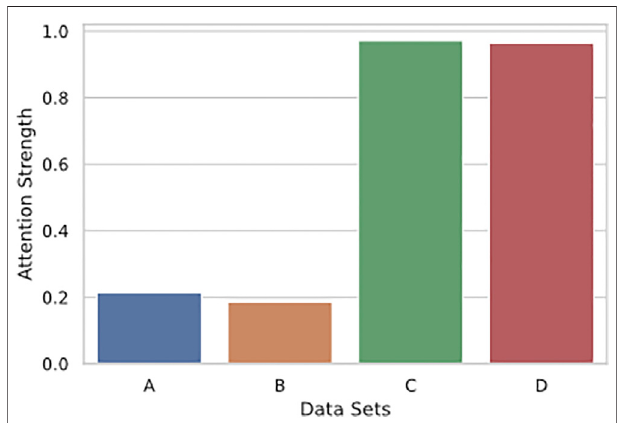
FIGURE 8 | Bar plot that shows means of the attention strength in each of four conditions. The y -axis describes the strength of the attention, ranging from 0.0 to 1.0. Names of the data sets correspond to the conditions described in Figure 6 . Standard deviation for different sets: SD (A) (cid:1)